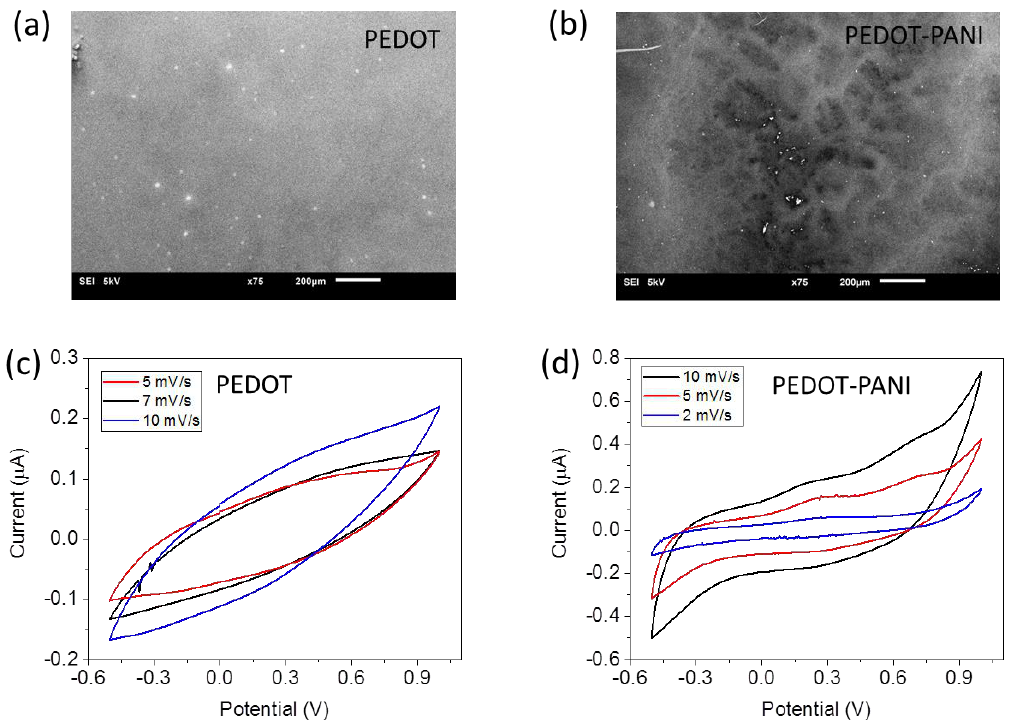
Figure 5. SEM images of the indicator electrode surface: ( a ) before the PANI deposition; ( b ) after the PANI deposition. CV curves at different scan rates in KCl 0.1 M ( c ) before the PANI deposition; ( d ) after the PANI deposition.